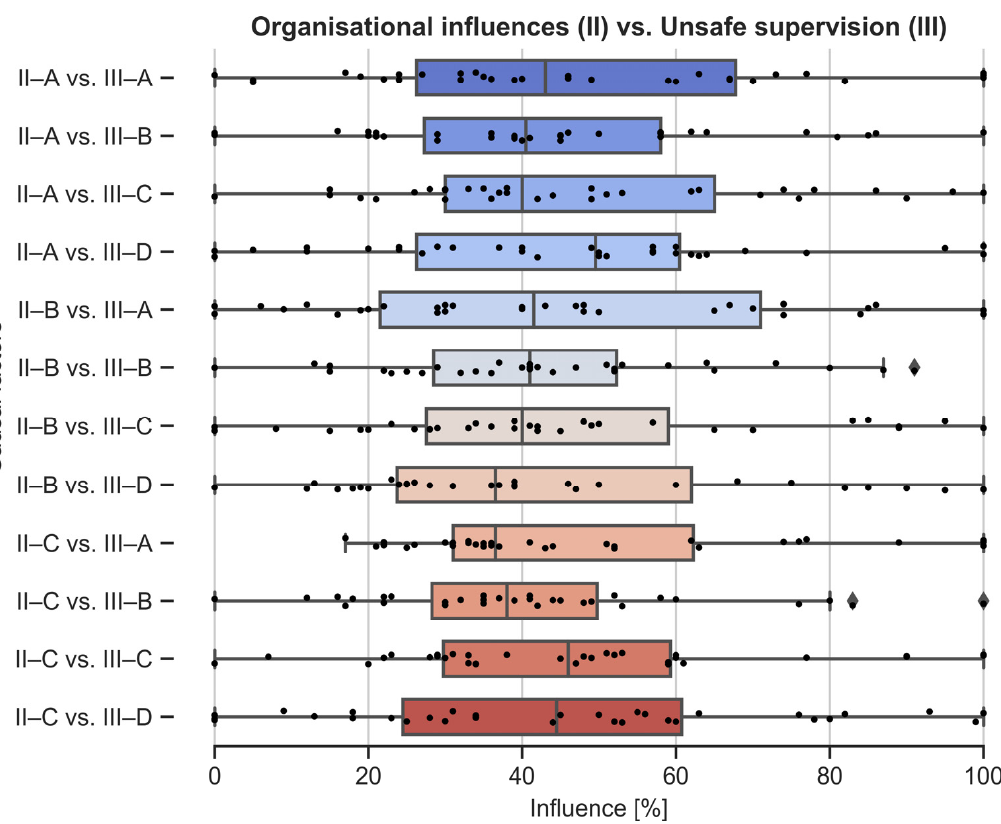
Figure 4. Box plots depicting the statistical analysis of data obtained on stage 2.